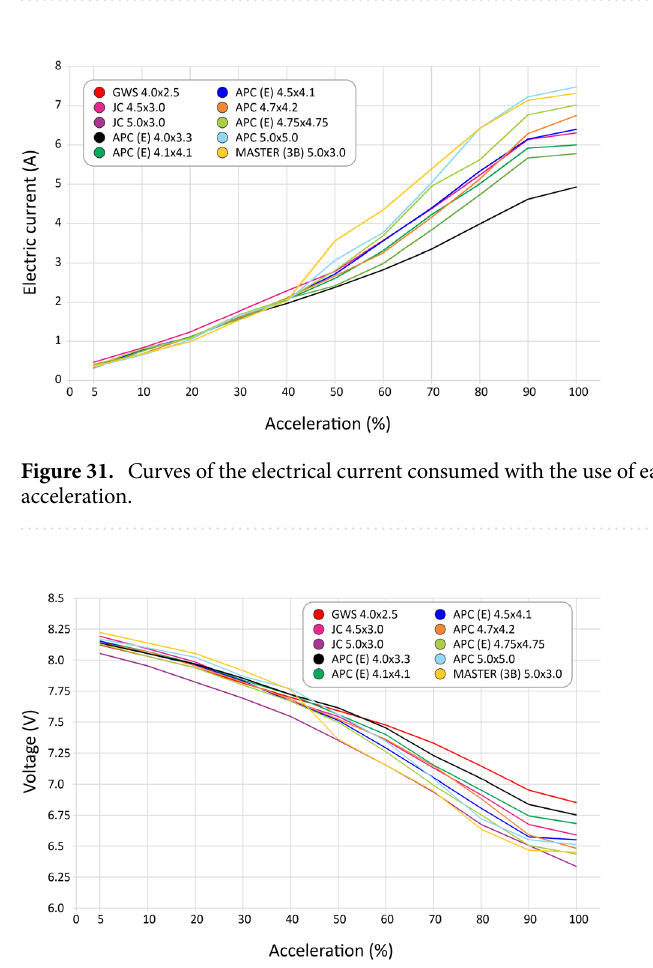
Figure 30. Curves for the thrust generated by propellers as a function of acceleration.